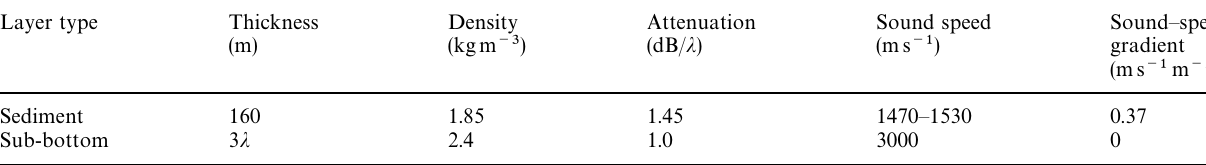
Table 1. Geoacoustic parameters for the Iceland-Faeroes environment Layer type